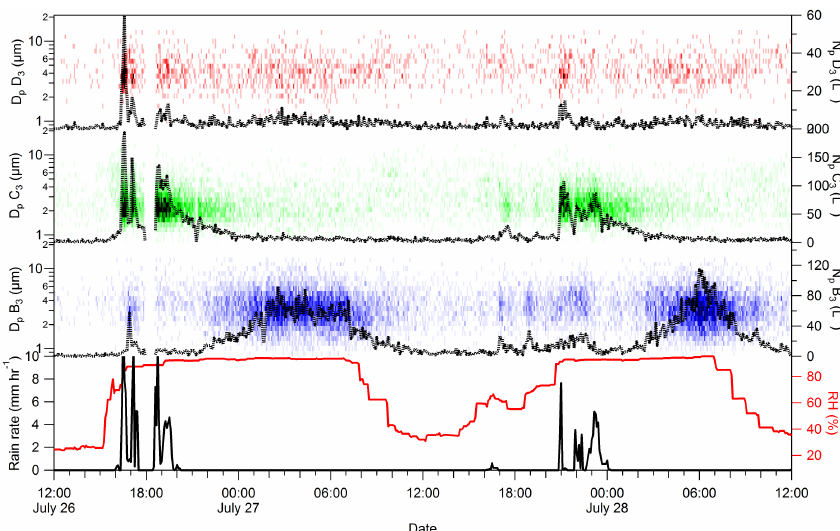
Figure 14. Response of cluster size distribution and number concentration (#L − 1 ) to rainfall and relative humidity. (a) Time series of D 3 size distribution (diameter in µm) (left) and cluster number concentration (right); (b) same as (a) but for C 3 ; (c) same as (a) but for B 3 ; (d) rain rate (mmh − 1 ) (left) and RH (%) (right). Rainfall data provided by A. Turnipseed at NCAR.